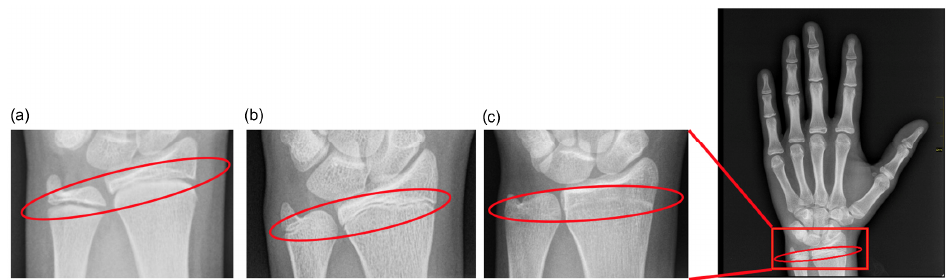
Figure 1. Bone age radiographs showing different degrees of growth plate ossification of the distal radius and ulna in girls aged 12 years ( a ), 15 years ( b ), and 18 years ( c ). Influential bone age assessment publications include the atlases by Greulich and Pyle (GP) [6], Tanner et al. (TW3) [7], and Gilsanz and Ratib (GR) [8]. The GP atlas was